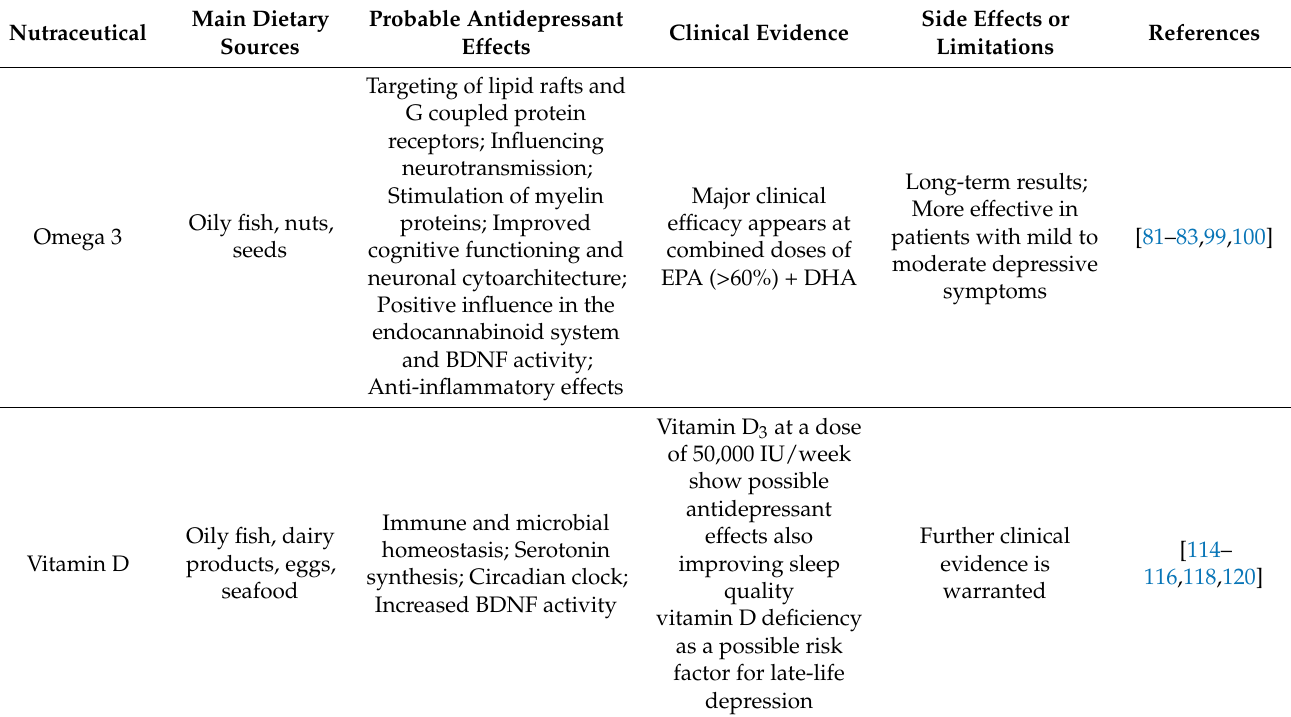
Table 1. A general summary of the main nutraceuticals, dietary sources and their preclinical/clinical evidence.